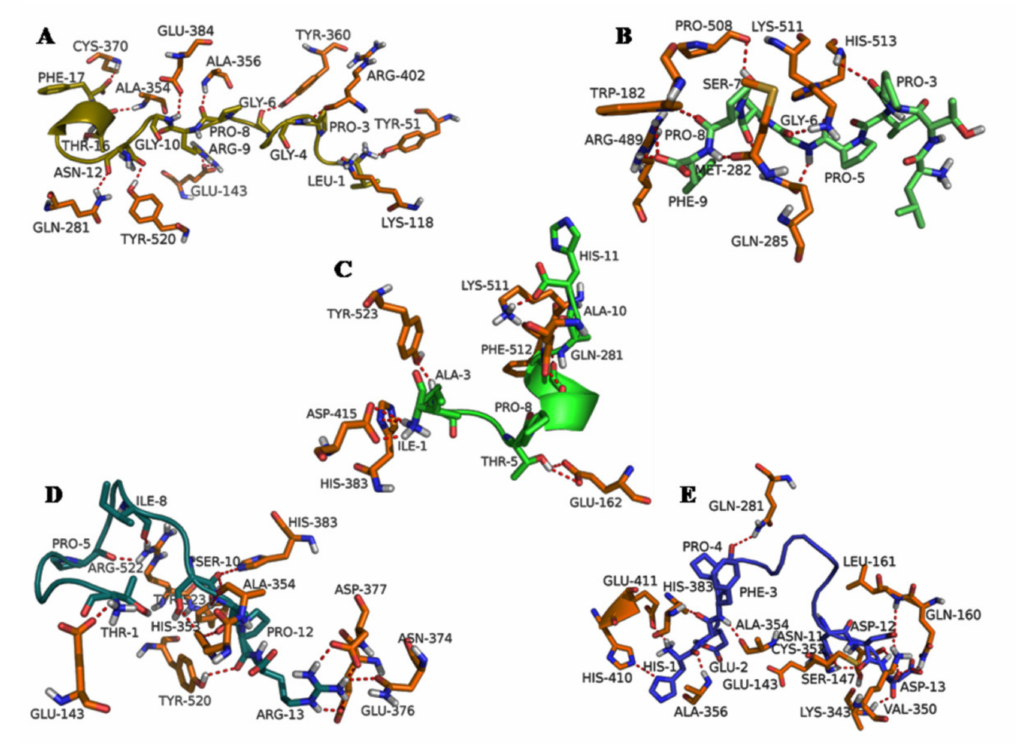
Figure 3. Docking poses of identified peptides (( A ) LNPGAGLPRGPNGADTF; ( B ) LTPVPGSPF; ( C ) IIAPTPVPAAH; ( D ) TIGAPDGIPSAPR; ( E ) HEFPGVVVGANDD) with angiotensin-converting enzyme (PDB file 1O86.pdb) at the core of the